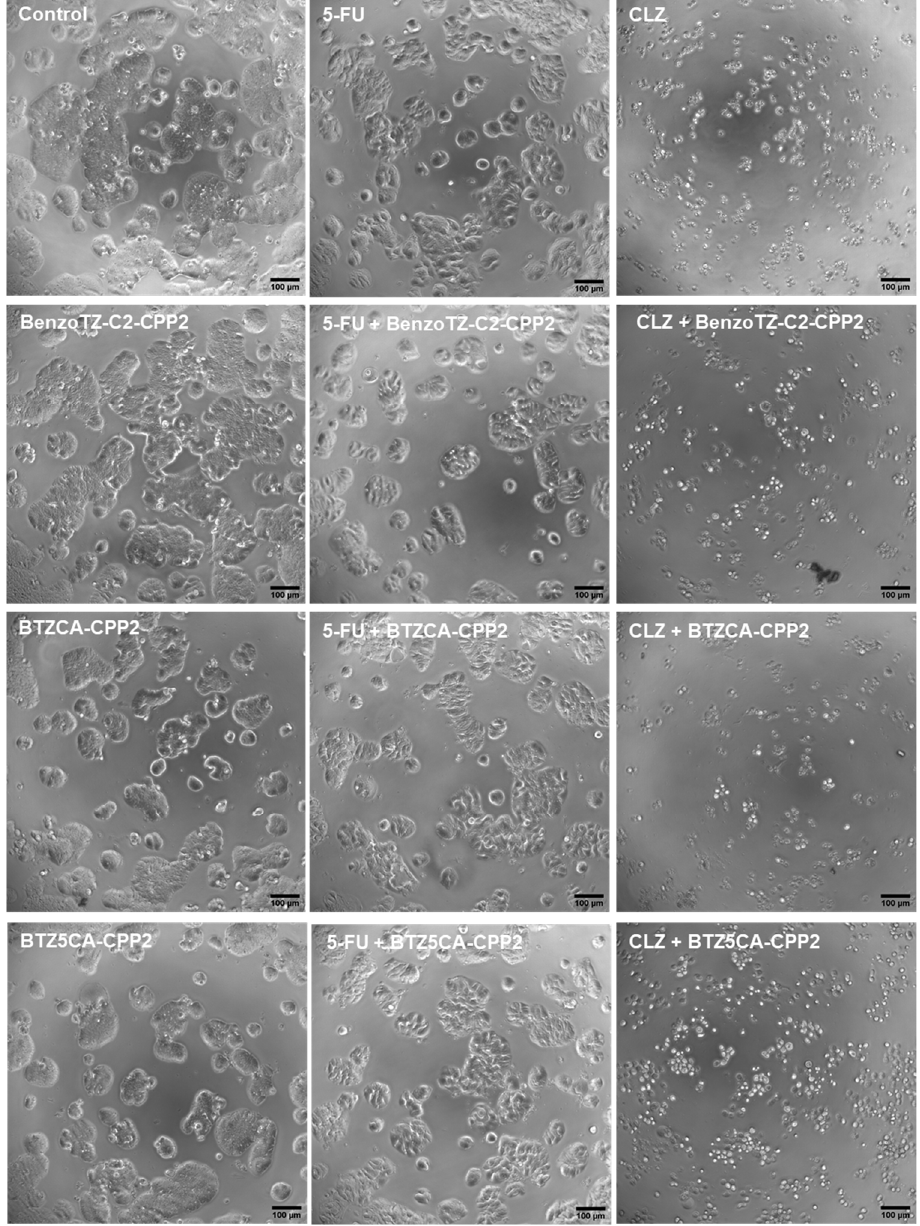
Figure 11. Microscopic visualisation of HT-29 treated with CPP2-thiazole derivates, both alone and combined with 5-FU and CLZ, at concentrations of 4 × IV. Representative images were obtained with a high contrast brightfield objective (10×) (LionHeart FX Automated Microscope) from three independent experiments. Scale bar: 100 µM.